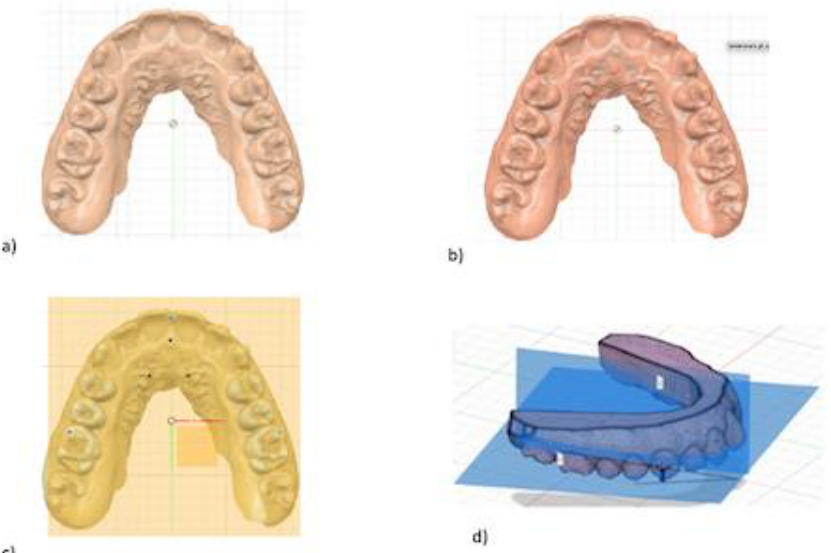
Figure 1. Digital procedure to evaluate the variation of occlusal plane. ( a ) occlusal view of maxillary stl model; ( b ) three points insertion of reference palatine plane; ( c ) maxillary occlusal plane passing through central incisors contact point to mesio-buccal cusps tips of maxillary first molars; ( d ) sagittal intersection between the two planes generating angle α.